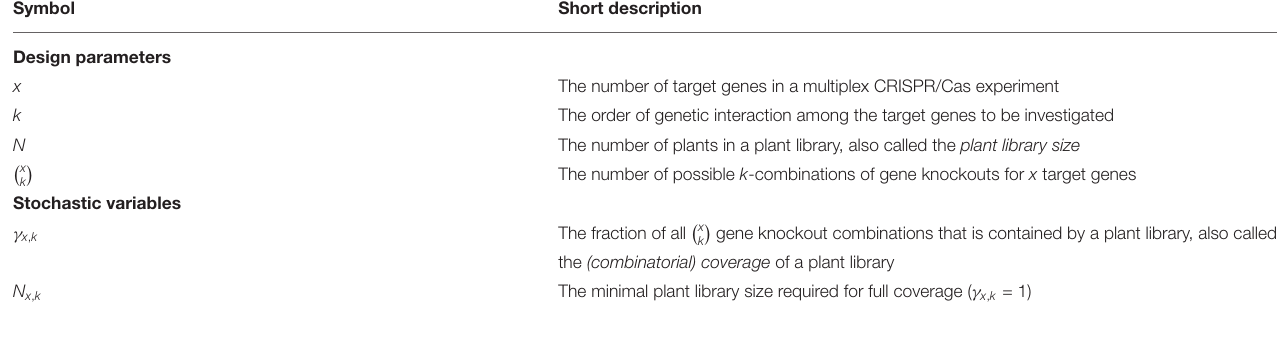
TABLE 1 | Central design parameters and stochastic variables of this study.